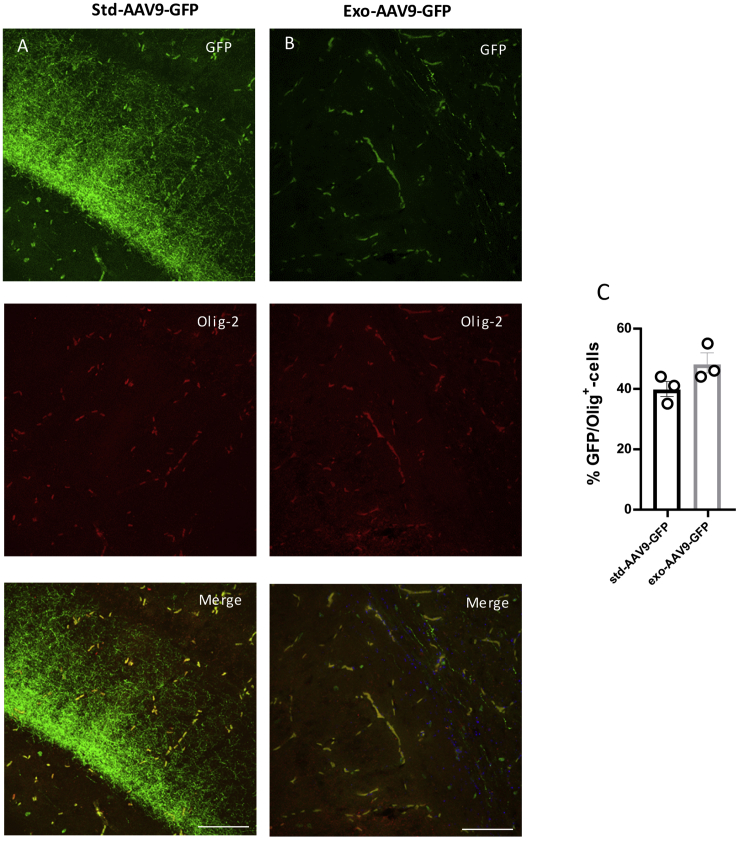
Oligodendrocyte Tropism of exo-AAV9 and std-AAV9 in the Granular Layer of the Hippocampus(A and B) Confocal imaging exhibits co-localization between GFP (green) and oligodendrocyte marker Olig-2 (red) after (A) std-AAV9 and (B) exo-AAV9 injection at 95 days. Images by a Leica SP8 confocal microscope at 40× magnification are shown. The combined image showing both channels (GFP-Olig-2) is on the right panel. Scale bar 20 μm. (C) Quantification of the GFP-positive oligodendrocytes transduced between std-AAV9 and exo-AAV9 expressed as percentages of co-localization between GFP and Olig-2 (n = 12). The data were analyzed by two-way ANOVA with Tukey post hoc test. Data are presented as mean ± SEM.